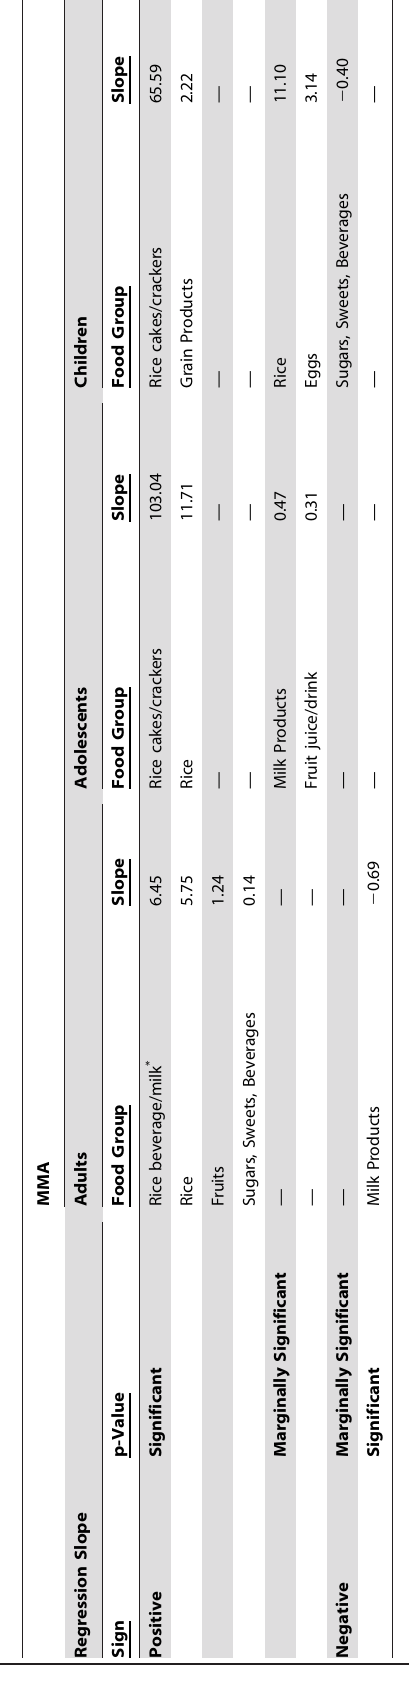
[nmol/L per kg consumed]. The displayed p-values are from identical models except that the dependent variable was ln-